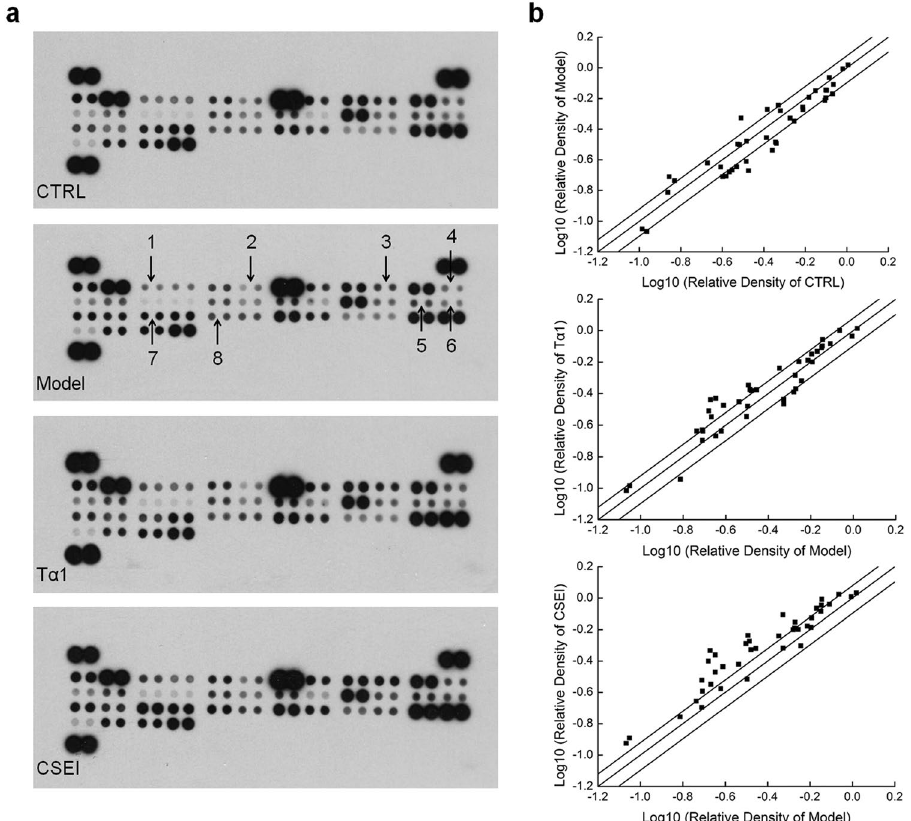
Figure 4. The effects of CSEI (4.50 mg/kg) and T α 1 (0.24 mg/kg) on 40 cytokines in mice spleens detected by Mouse Cytokine Array Panel A Kit. ( a ) Graphical representation of cytokine expressions. The arrows indicate the factors with a change of > 50% (CSEI group versus model group). 1. G-CSF; 2. IL-1 β ; 3. IL-2; 4. IL-23; 5. IL- 27; 6. Eotaxin; 7. KC; 8. JE. ( b ) Scatter diagram of 40 cytokines. The relative density is the ratio of the absolute value and the reference spot